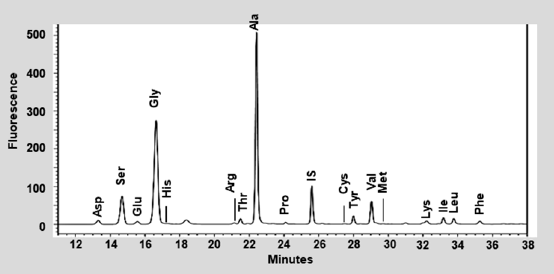
Figure 3. High-performance liquid chromatographic analysis of the silk peptide. HPLC chromatogram for the SP. Abbreviations: Ala, Alanine; Cys, Cysteine; Asp, Aspartic acid; Glu, Glutamic acid; Phe, Phenylalanine; Gly, Glycine; His, Histidine; Ile, Isoleucine; Lys, Lysine; Leu, Leucine; Met, Methionine; Pro, Proline; Arg, Arginine; Ser, Serine; Thr, Threonine; Val, Valine; Tyr, Tyrosine; IS, Interpolation of standard (L-2-aminobutyric Table 1. Nutrient composition of the silk peptide.